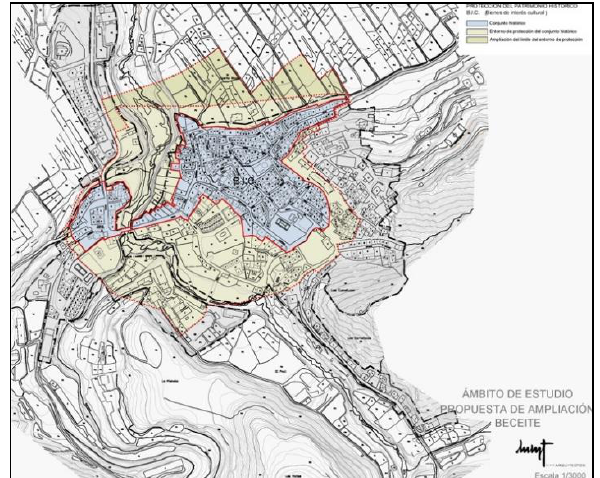
Figure 2. The Study of Beceite proposed an extension of its buffer zone (in brown) to the north (Murría,